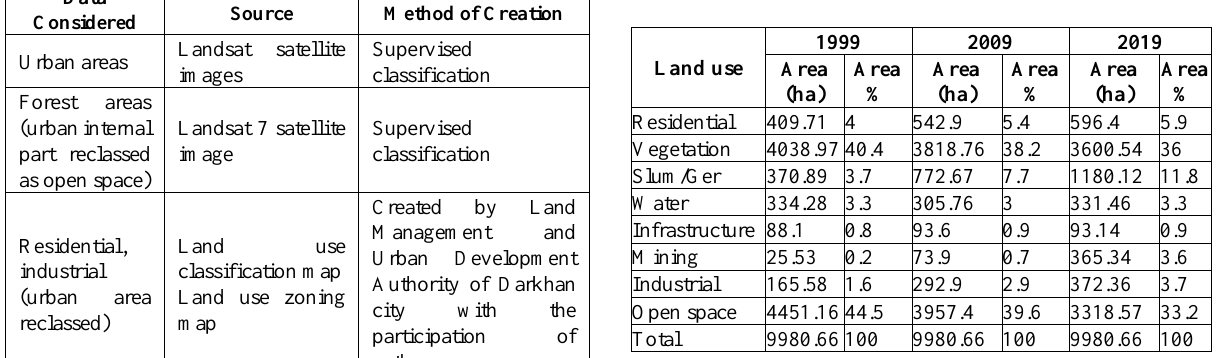
Table 4. LUCC of Darkhan city (1999, 2009 and